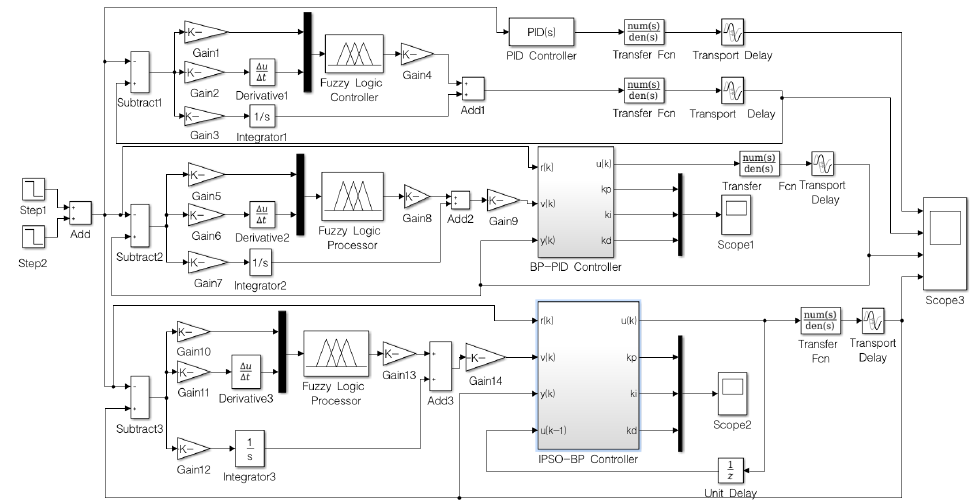
Figure 11. Simulation model of fertilizer–liquid mixing pH control system.